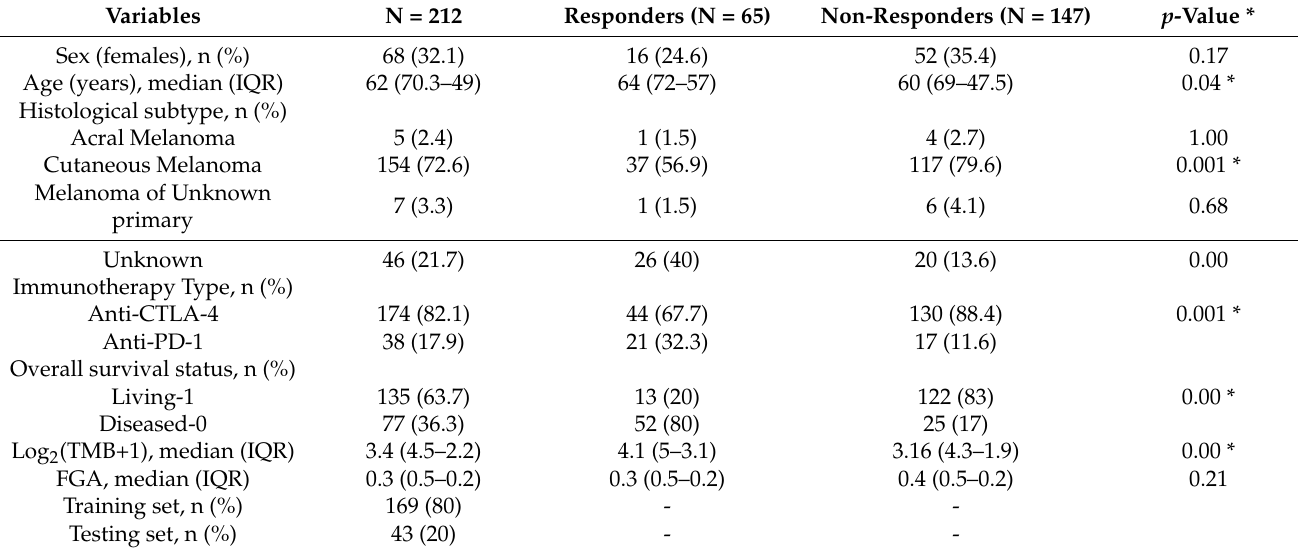
Table 1. Demographic and clinical characteristics of patients included in the RFC7